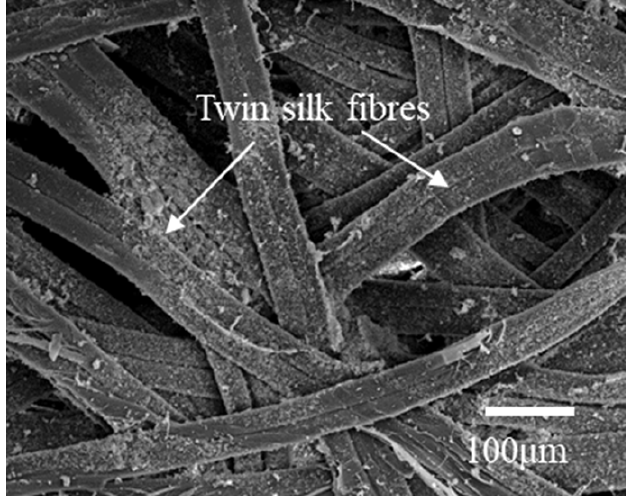
Figure 5. The non-woven cocoon structure from the A. pernyi . The SEM images in Figures 6 and 7 show the micro-structures of different A. pernyi cocoon layers (outer layer, middle layer, and inner layer) from two source regions at different magnifications to make a comparison on their morphologies. Cocoons with this structure always have a graded layer structure, with the porosity decreasing through the thickness direction from the outer layer to the inner layer [14]. Compared with the cocoon of the middle and the inner layers, the pores in the cocoon of the outer layer are more numerous and larger. The outer silk is loose and round, while the inner silk is interlaced tightly and is smooth and flat, as can be seen in Figure 8. It is seen in Figures 6 and 7 that the inner layer has a lower porosity (i.e., a higher silk density), which can be certified by the results shown in Table